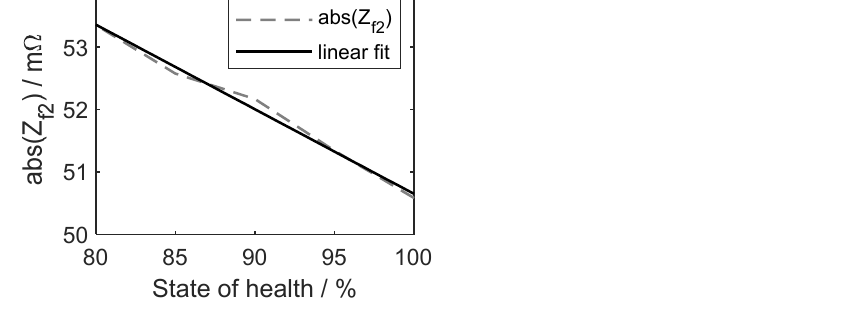
Figure 5. Averages of 1 kHz impedance at each cell SoH (dotted line) and linear fit (solid line). The fitted line in Figure 5 is obtained through linear regression of these 1 kHz impedances measured at each SoH, and it is expressed as Equation (7).